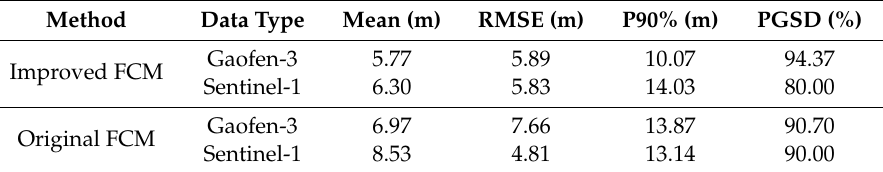
Table 3. Quantitative evaluation in the sub-region A of Bohai.